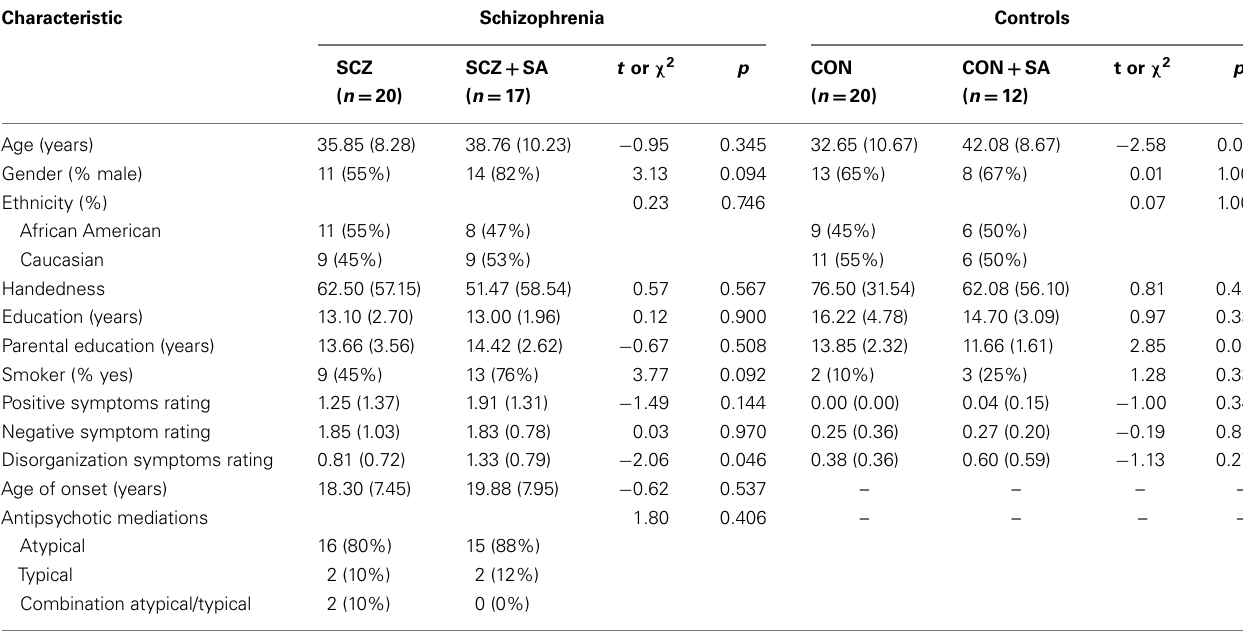
Table 1 | Demographic characteristics and clinical characteristics of participants .